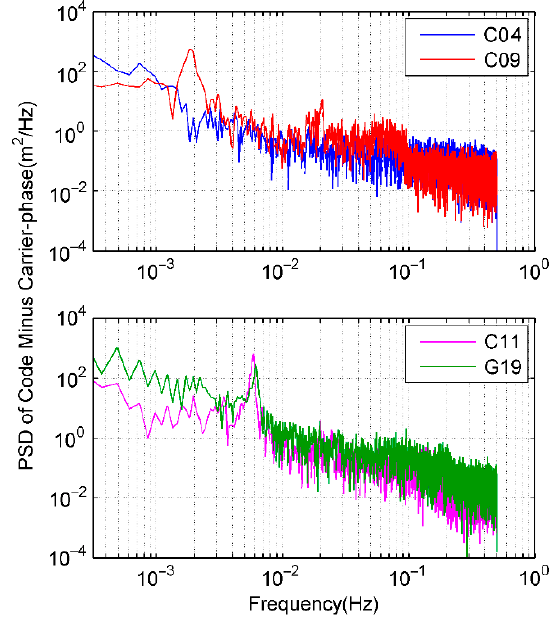
Figure 7. PSD of CMC on DOY 310.